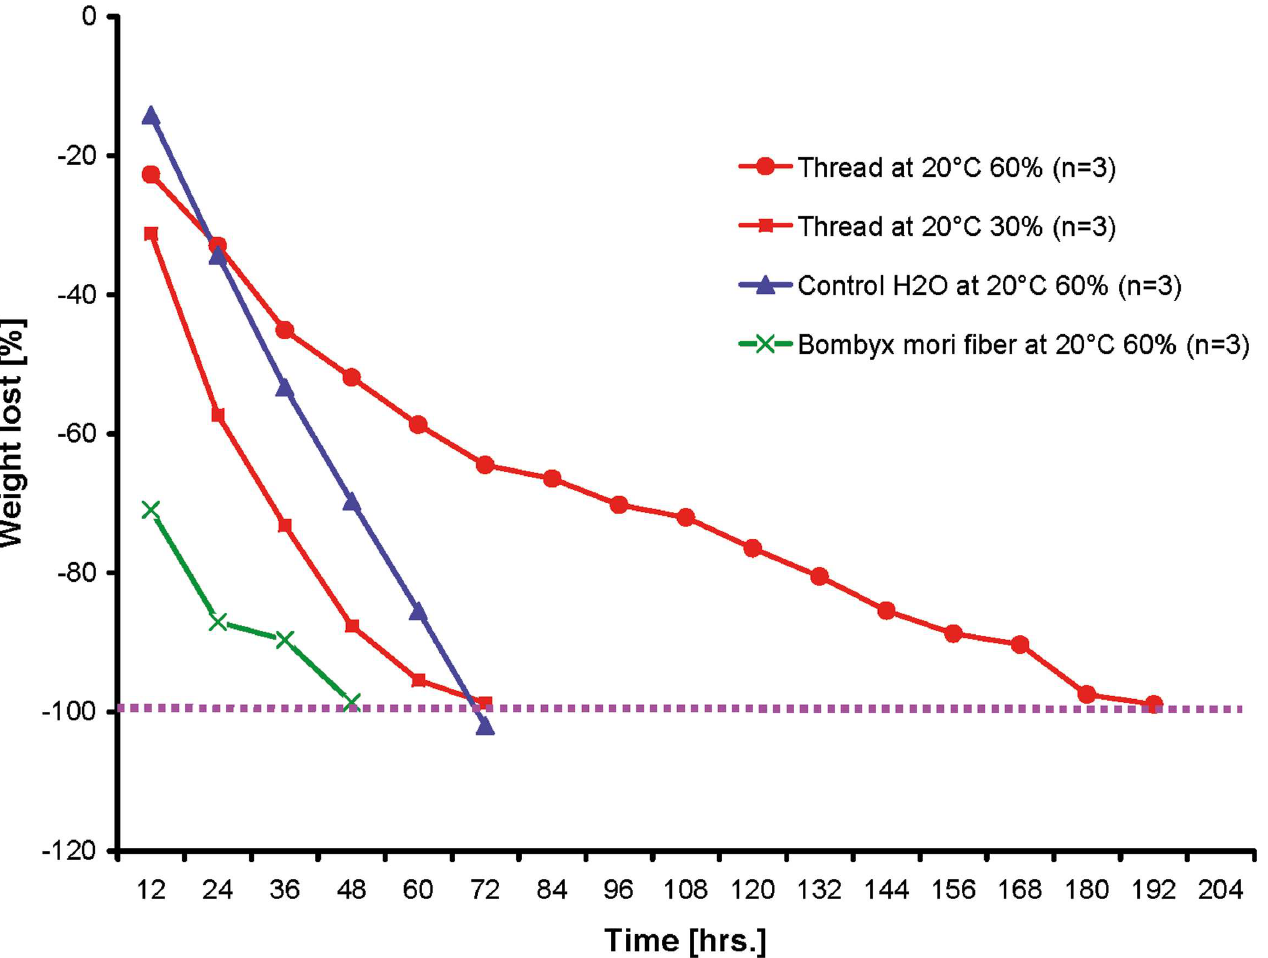
Fig 5. Under conditions of high humidity (60%), a low water loss over time (8 days) was determined (red circled line), while at a lower humidity (30%, red squared line) there was a fast weight loss (after 3 days). In relationto this, water (blue line) showeda more constant evaporation rate at 60% humidity and likewisereachedits final minima after 3 days. Bombyx mori silkworm fibres (green line), wateredfor 24 h, evaporated within 2 days, showingthe highestweight loss within the first 12